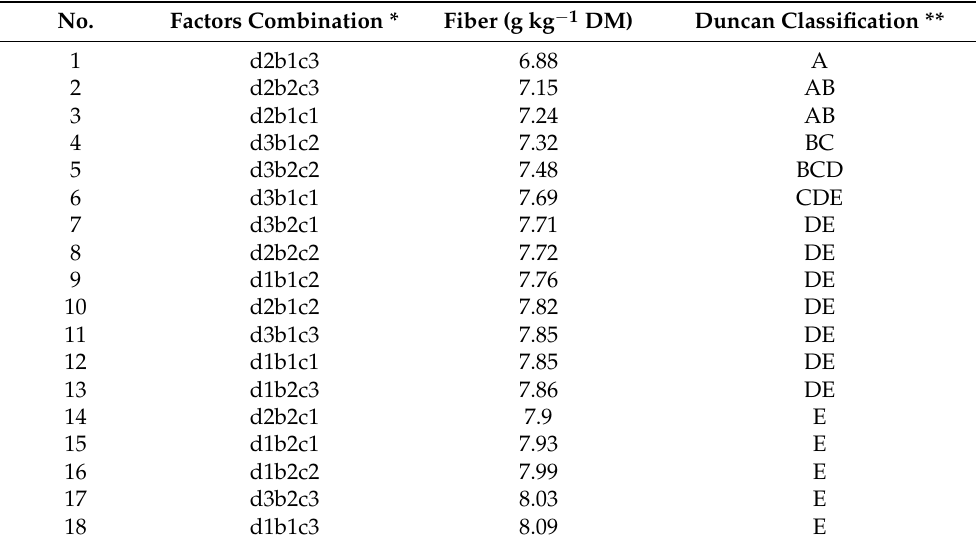
Table 8. Synthesis of soybean fiber content (g kg − 1 DM) comparisons by technological factors (Duncan classification of the average values for